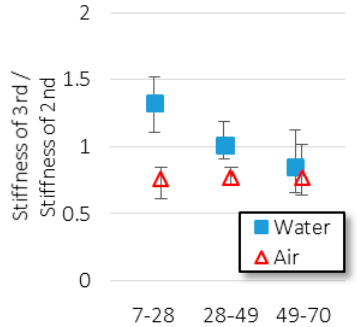
Figure 14. Ratios between flexural stiffness of 3rd loading and that of 2nd loading (different crack inducement times).